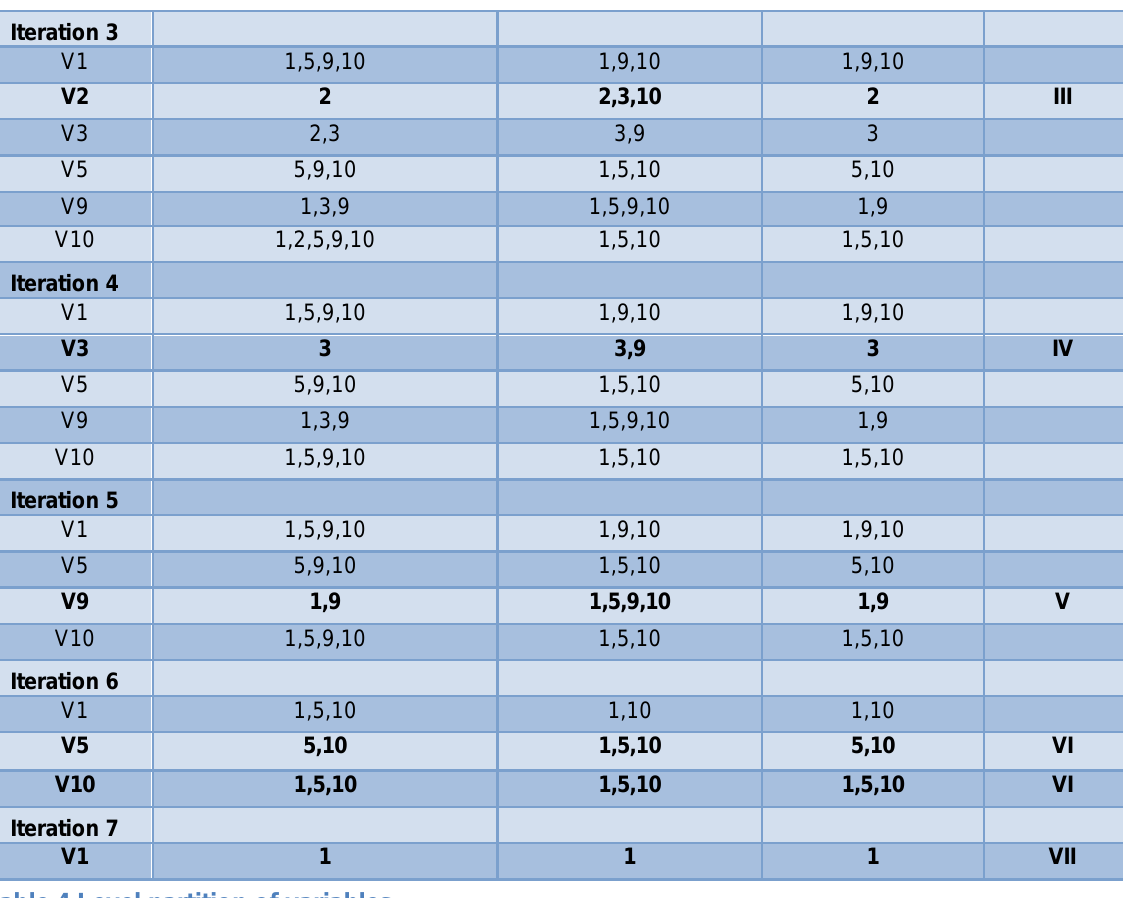
Table 4 Level partition of variables